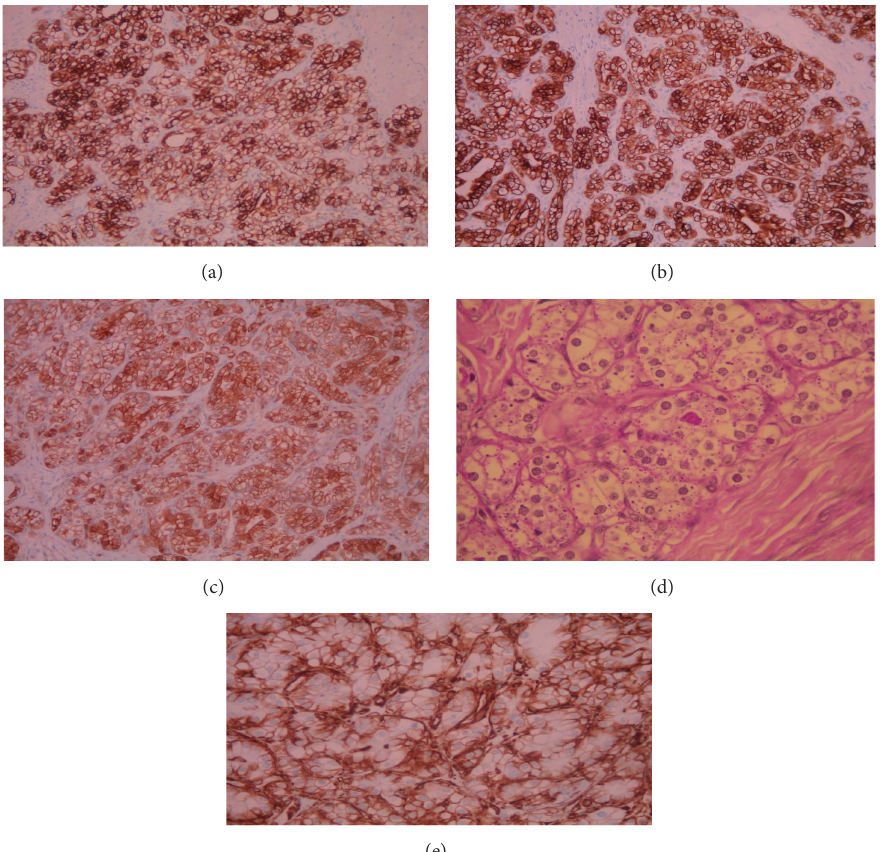
Figure 3: Immunohistochemical examination. (a) The tumor cells are positive for Cytokeratin-7 (Immunostain × 200). (b) The tumor cells are positive for Cytokeratin-8/Cytokeratin-18 (Immunostain × 200). (c) The tumor cells are positive for NSE (Immunostain × 200). (d) Intracytoplasmic PAS positive granules (PAS × 400). (e) Focal basolateral membranous staining for vimentin (Immunostain ×